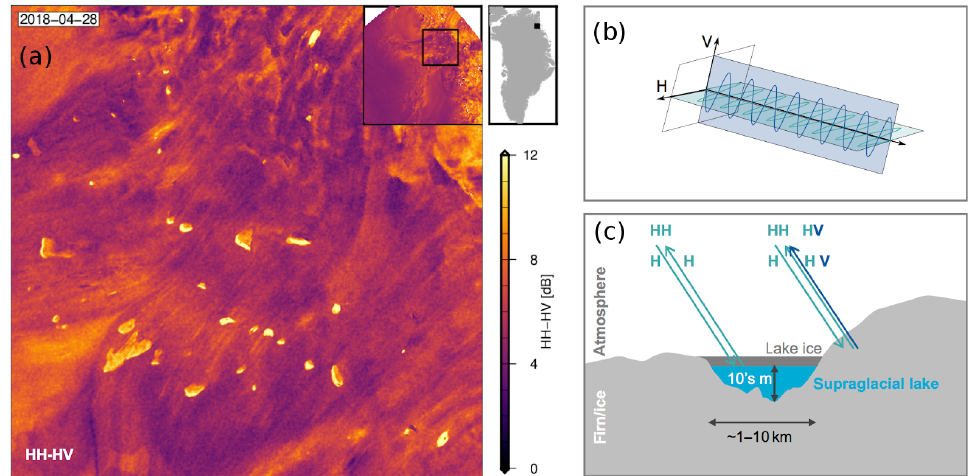
Figure 23. (a) Detection of supraglacial lakes using polarimetry with Sentinel-1. Bright yellow denotes surface scattering, which arises from the flat transition between lake ice and water, as shown schematically on the right. (b, c) A schematic representation of the principle of the polarimetric